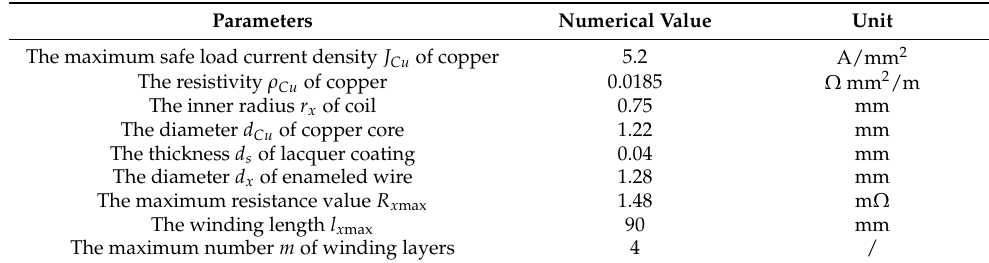
Table 4. The selection and calculation results of the parameters related to the magnetic field